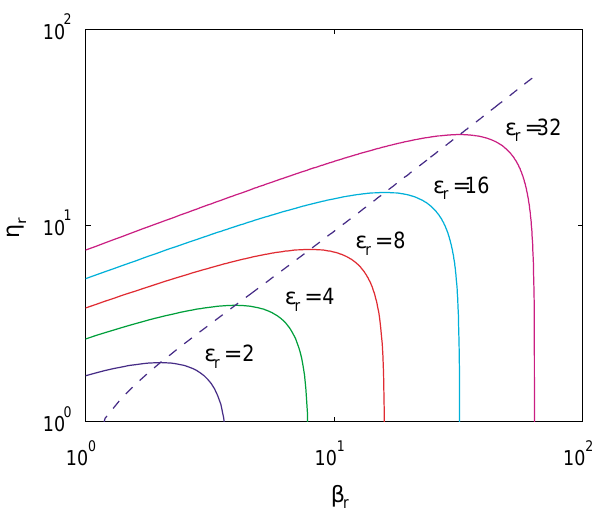
FIG. 2. (Color) Relative dispersion h r versus relative beta func- tion b r at the center of bend in TME cell for five different values of the emittance detuning factor ´ r ( (cid:1) 2 , 4, 8, 16, and 32). The dashed curve follows the maximum values of h r and relates to Eq. (27).